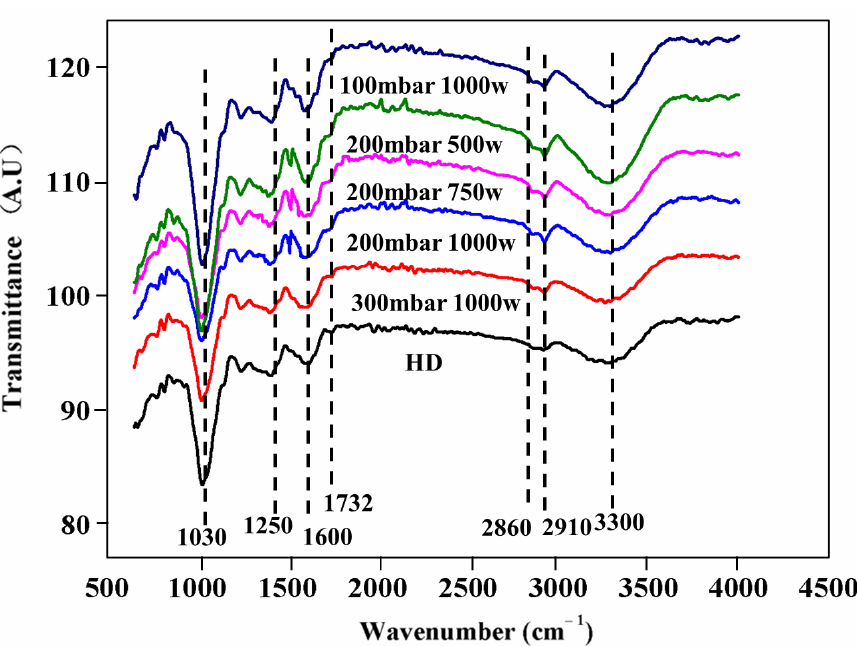
Figure 4. ATR-IR of cucumber residues obtained from HD and VMHD.